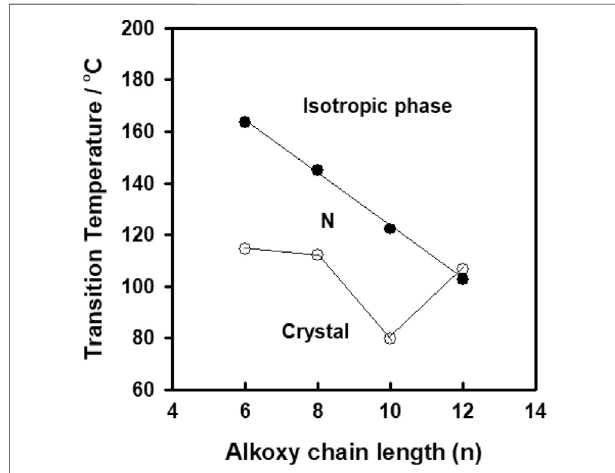
FIGURE 6 | Effect of terminal alkoxy-group on the mesophase behavior of the series An .